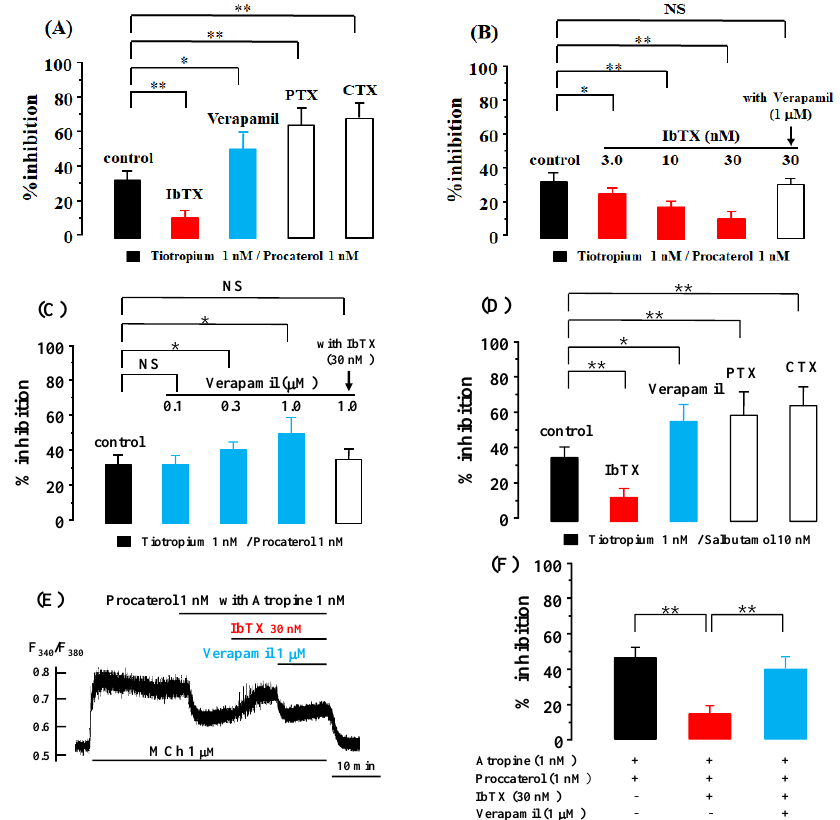
Figure 2. Mechanisms of synergistic effects of the combination of β 2 -adrenergic receptor agonists with muscarinic receptor antagonists. ( A ) Values of percent inhibition of procaterol (1 nM) with tiotropium (1 nM) against MCh (1 µ M)-induced contraction (control) in the presence of IbTX (30 nM), or verapamil (1 µ M), and after incubation with pertussis toxin (1 µ g/mL, PTX) and cholera toxin (2 µ g/mL, CTX) for six hours; ( B ) Values of percent inhibition of procaterol with tiotropium against MCh-induced contraction in the presence of IbTX (3.0–30 nM) without/with verapamil (1 µ M); ( C ) Values of percent inhibition of procaterol with tiotropium against MCh-induced contraction in the presence of verapamil (0.1–1.0 µ M) without/with IbTX (30 nM). ( D ) Values of salbutamol (10 nM) with tiotropium (1 nM) against MCh (1 µ M)-induced contraction under the same experimental conditions as 2A; ( E ) A typical record of F 340 /F 380 demonstrating the effect of IbTX (30 nM) and verapamil (1 µ M) on a combination of procaterol (1 nM) with atropine (1 nM) in the presence of MCh (1 µ M); ( F ) Values of percent inhibition of F 340 /F 380 in MCh (1 µ M)-induced contraction under the condition of procaterol with atropine in the absence and presence of IbTX and verapamil. MCh: methaxholine, IbTX: iberiotoxin, NS: not significant, *: p < 0.05, **: p <